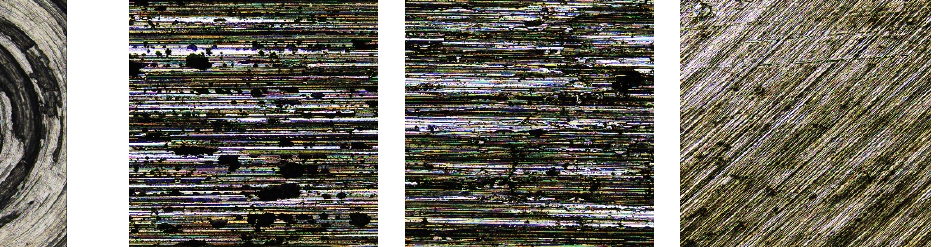
Before friction